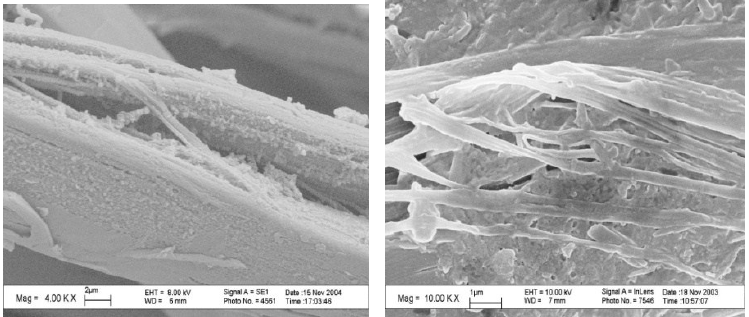
Figure 2. Microfibrisl on PBO fiber